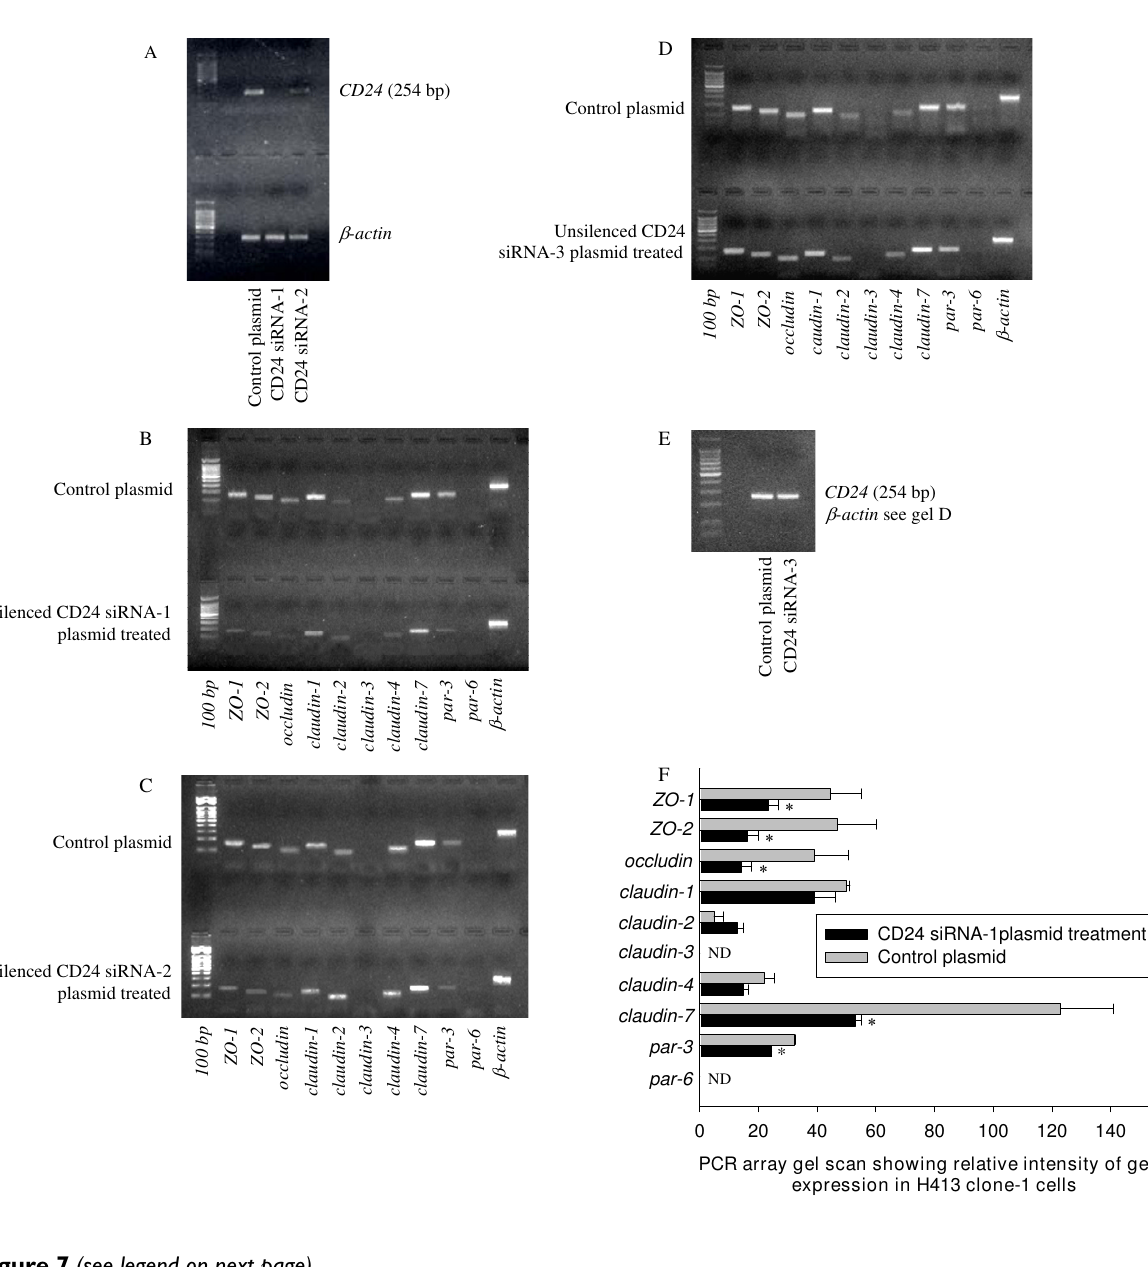
Figure 7 (see legend on next